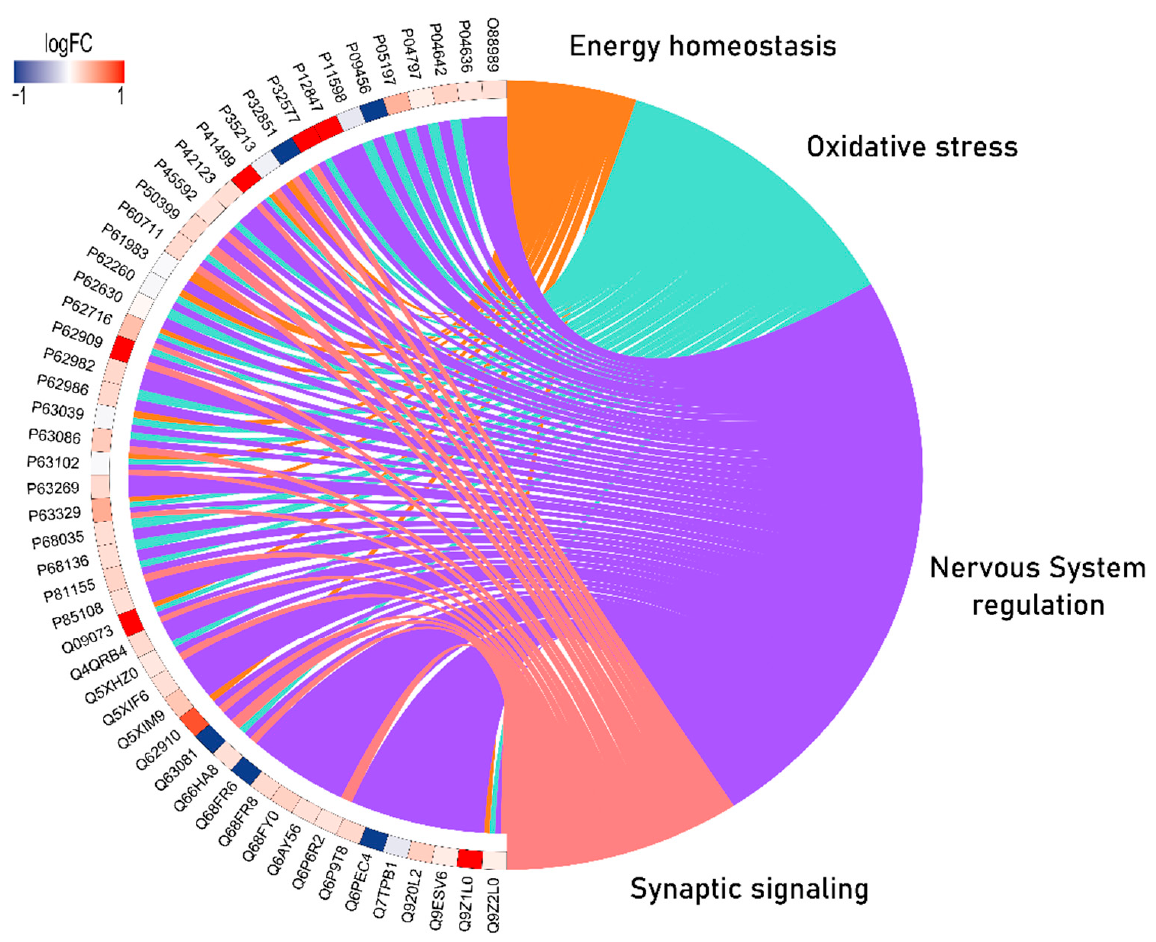
Figure 4. Circos plot of protein-protein interactions (PPIs) resulting from the over-representation analysis of the cerebellar proteomes of rats exposed to MeHg. The results are organized into the categories of energy homeostasis (orange), oxidative stress (light green), nervous system regulation (purple), and synaptic signaling (warm pink). Blue-scale proteins were downregulated and red proteins were upregulated in the MeHg group compared to the control group.